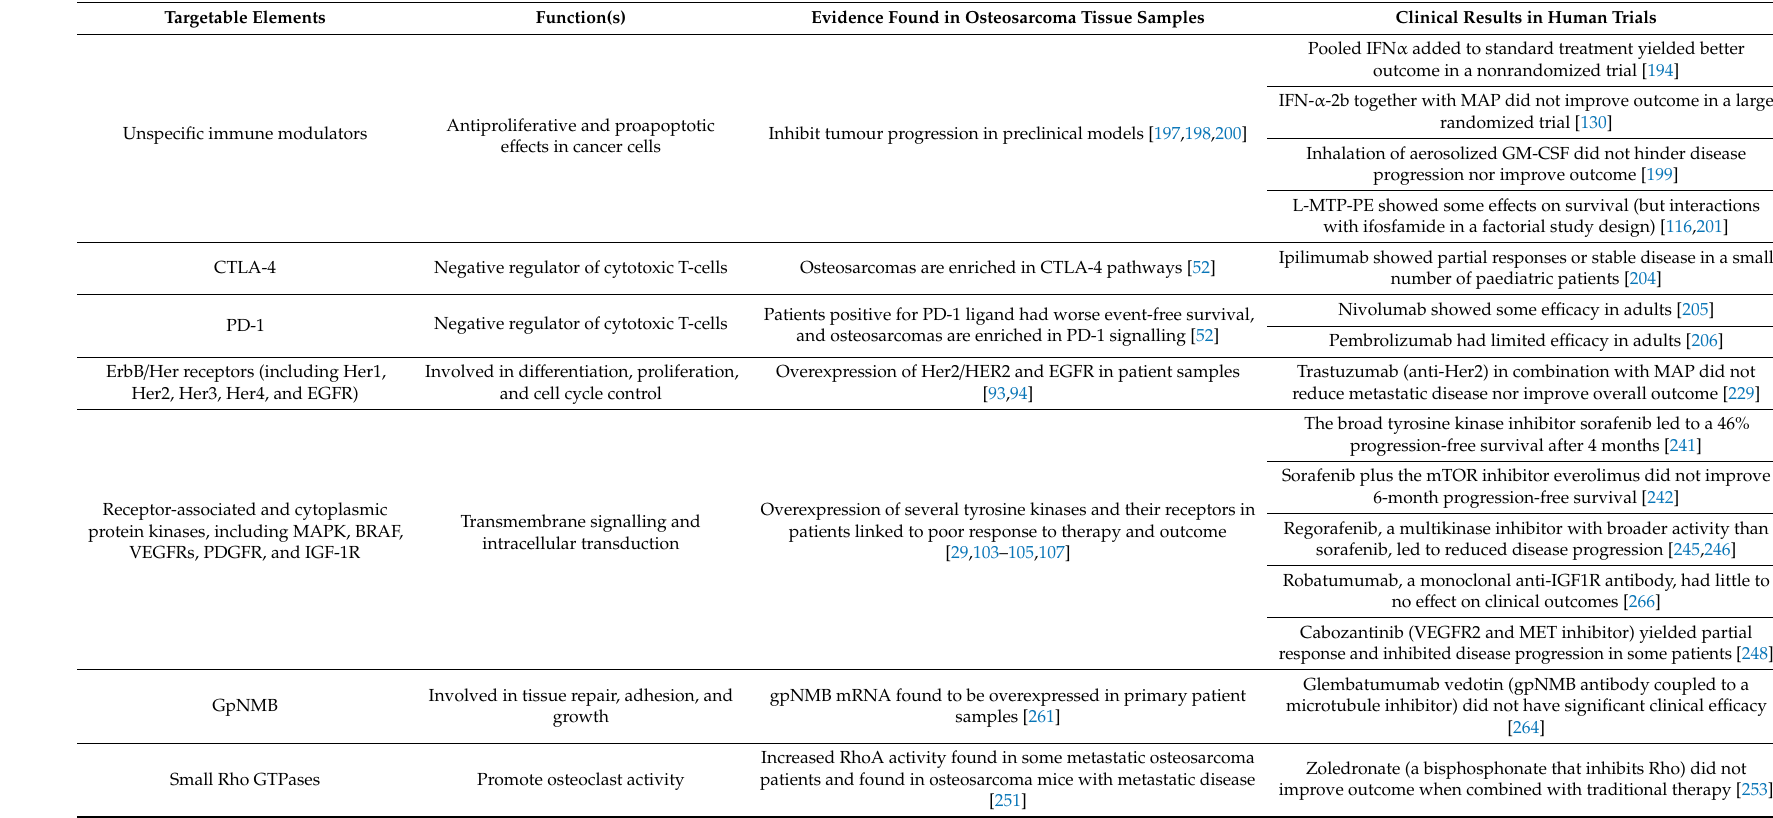
Table 1. Overview of novel therapies evaluated in clinical trials of